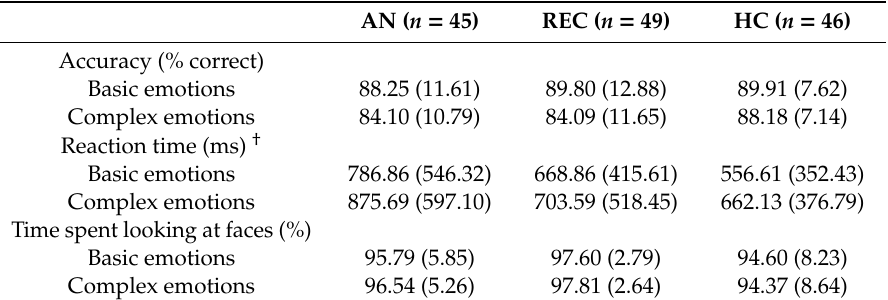
Table 2. Mean (SD) performance and attention during the films expression